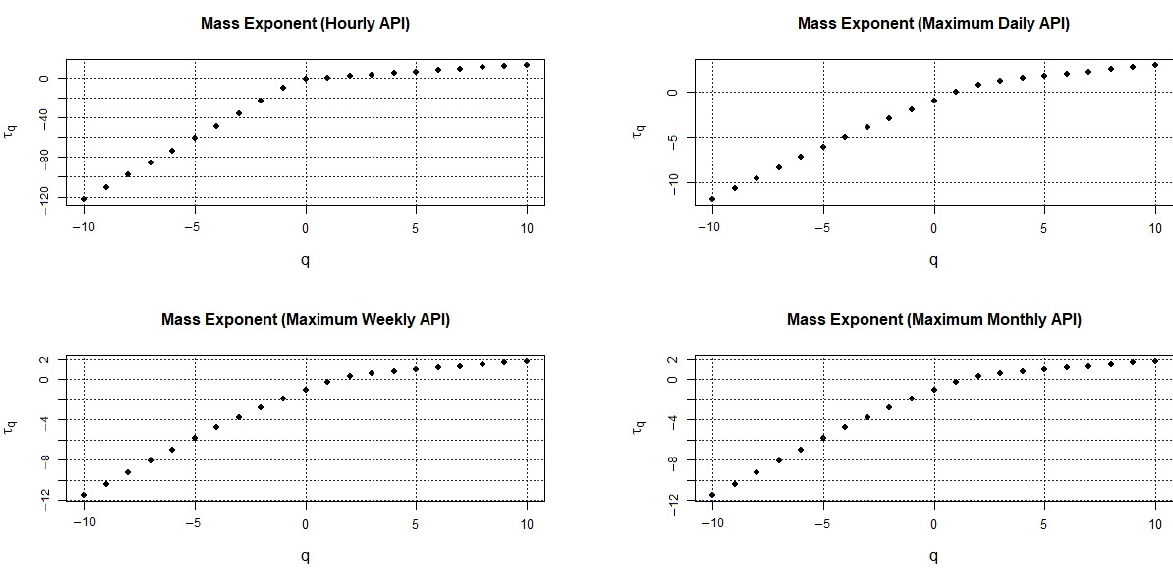
Figure 5. Nonlinear relationships between τ (q) and q for hourly API series in Klang.